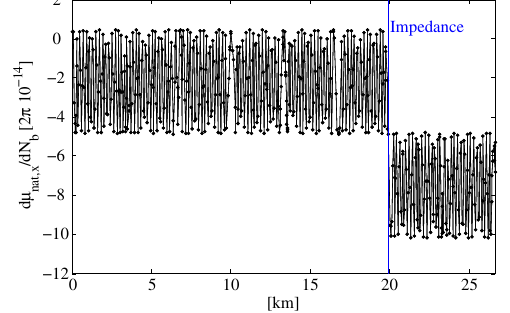
FIG. 3. Natural horizontal phase advance beating versus in- tensity calculated with HEADTAIL simulations of a broadband impedance placed close to the IP7 in the LHC at 20 km. An horizontal kick is used as excitation.